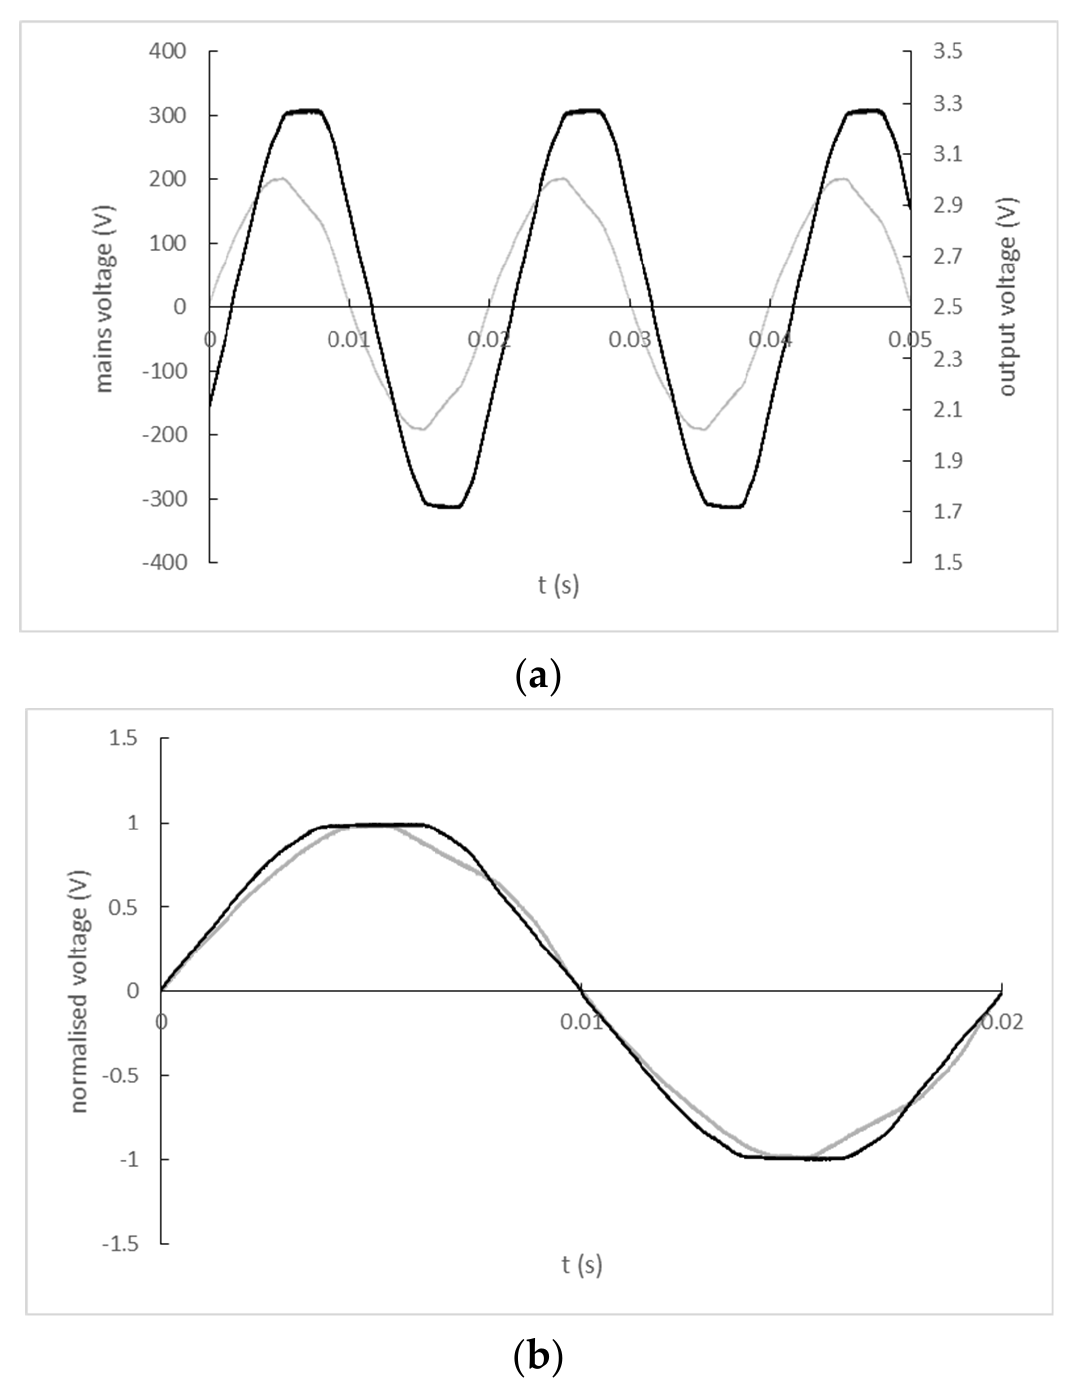
Figure 11. ( a ) The input and output signal record of ZMPT101B single-phase AC voltage sensor (black line—mains; grey line—output); ( b ) Normalized and zero-crossing time shift-corrected input and output waveforms of ZMPT101B single-phase AC voltage sensor (black line—mains; grey